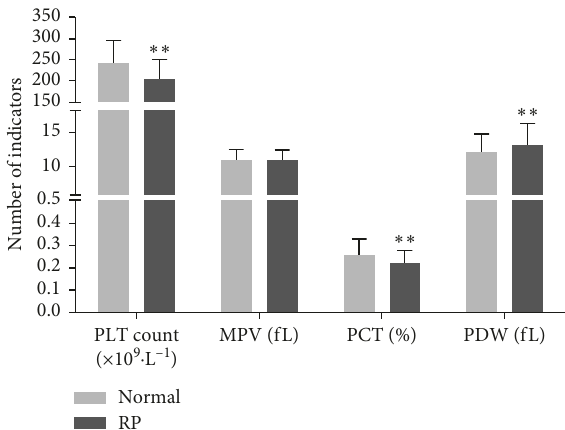
Figure 3: Comparison of PLT indicators between the normal and RP group. Two independent samples T -tests were performed for comparing the data of PLT. Two independent samples rank sum test was performed for the other data. p < 0 . 05 was considered statistically significant. ∗∗ p < 0 . 01 was considered statistically very